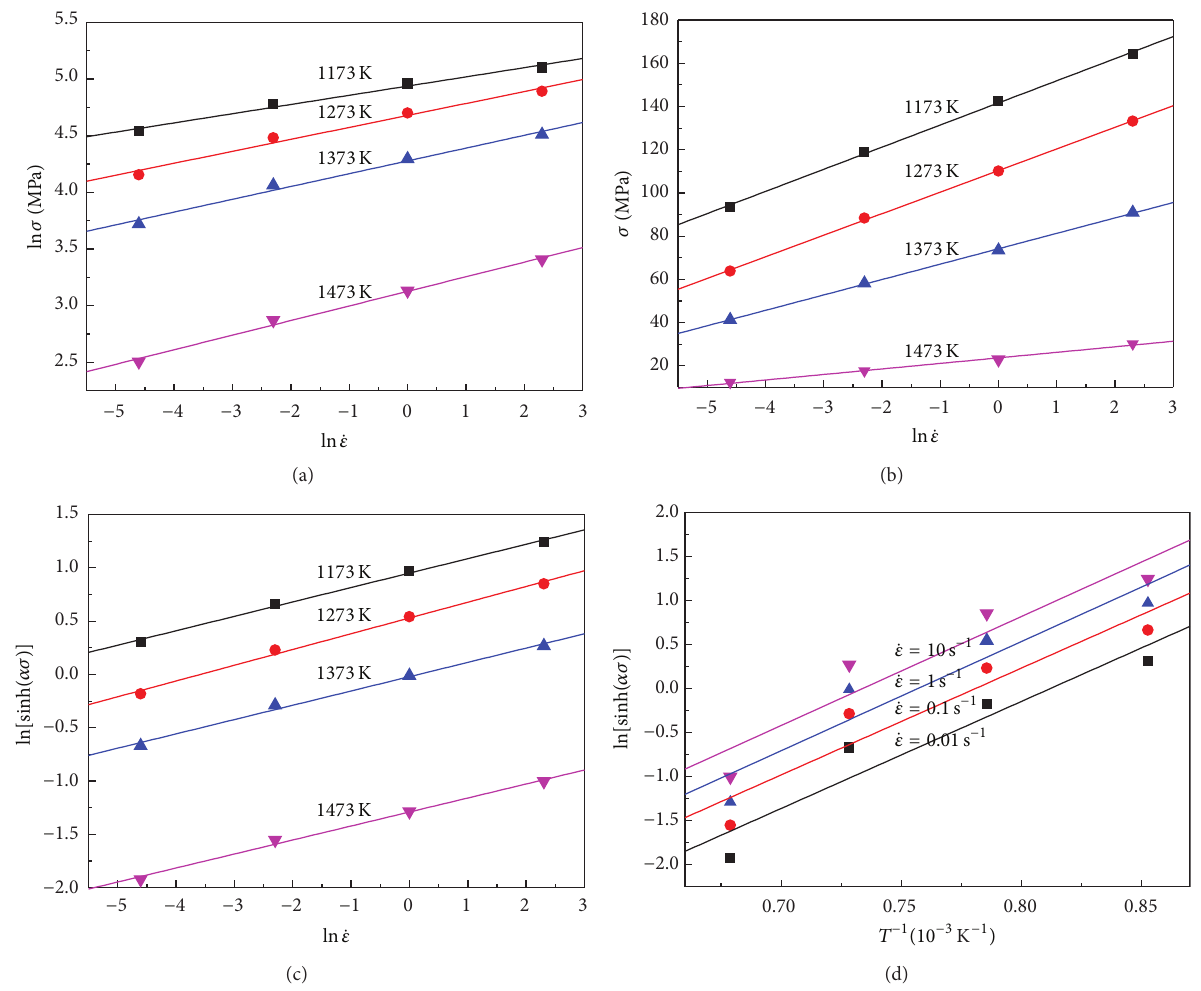
Figure 2: The relationships between (a) ln 𝜎 and ln ̇𝜀 , (b) 𝜎 and ln ̇𝜀 , (c) ln [ sinh (𝛼𝜎)] and 𝑇 −1 , and (d) ln [ sinh (𝛼𝜎)] and ln ̇𝜀 .